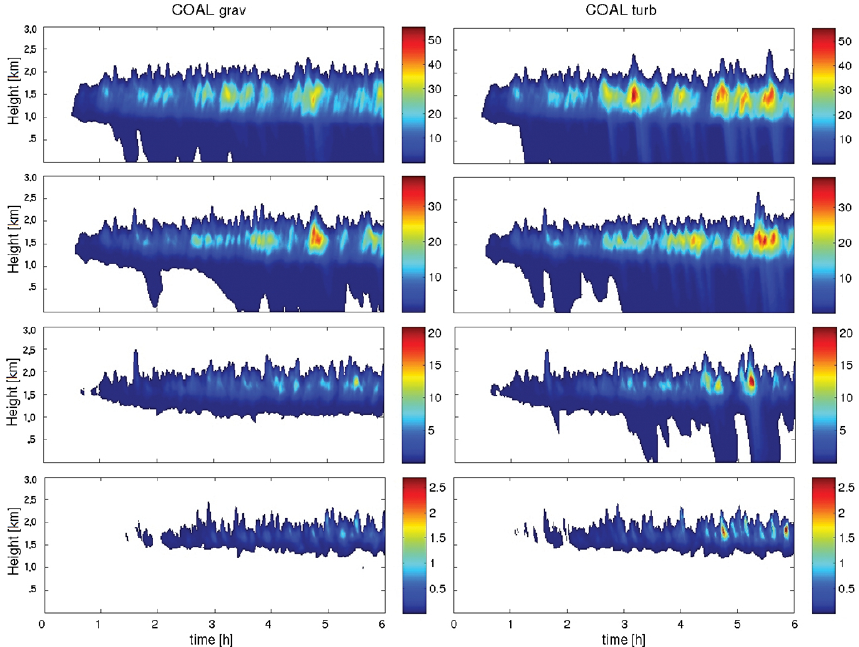
Fig. 10. As in Fig. 9 but for above but for the precipitating (drizzle/rain) water mixing ratio. Color scale depicts units of mgkg − 1 .